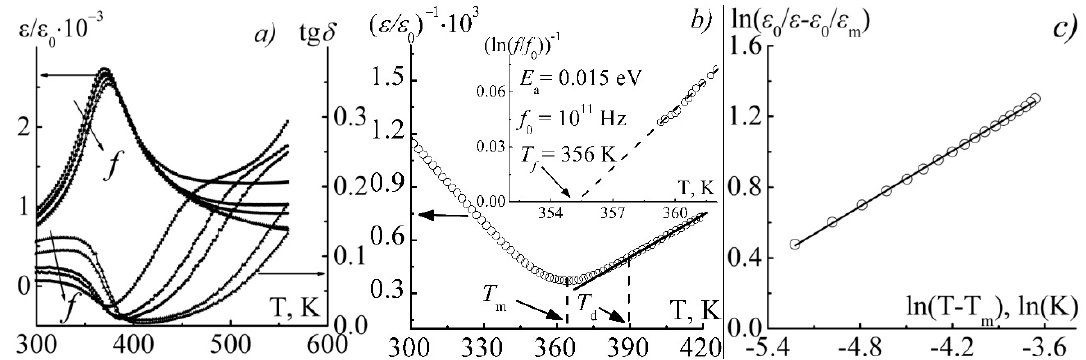
Figure 6. Dependences ε / ε 0 ( Т ), tg δ ( Т ) ( а ) f = 10 ÷ 10 5 Hz ( a ) (the direction of f growth is indicated by an arrow), (ln( f / f 0 )) − 1 ( Т ) and ( ε / ε 0 ) − 1 ( Т ) at f = 10 5 Hz ( b ), ln( ε 0 / ε − ε 0 / ε m ) on ln( Т − T m ) ( c ) in BSN-50 ceramic.